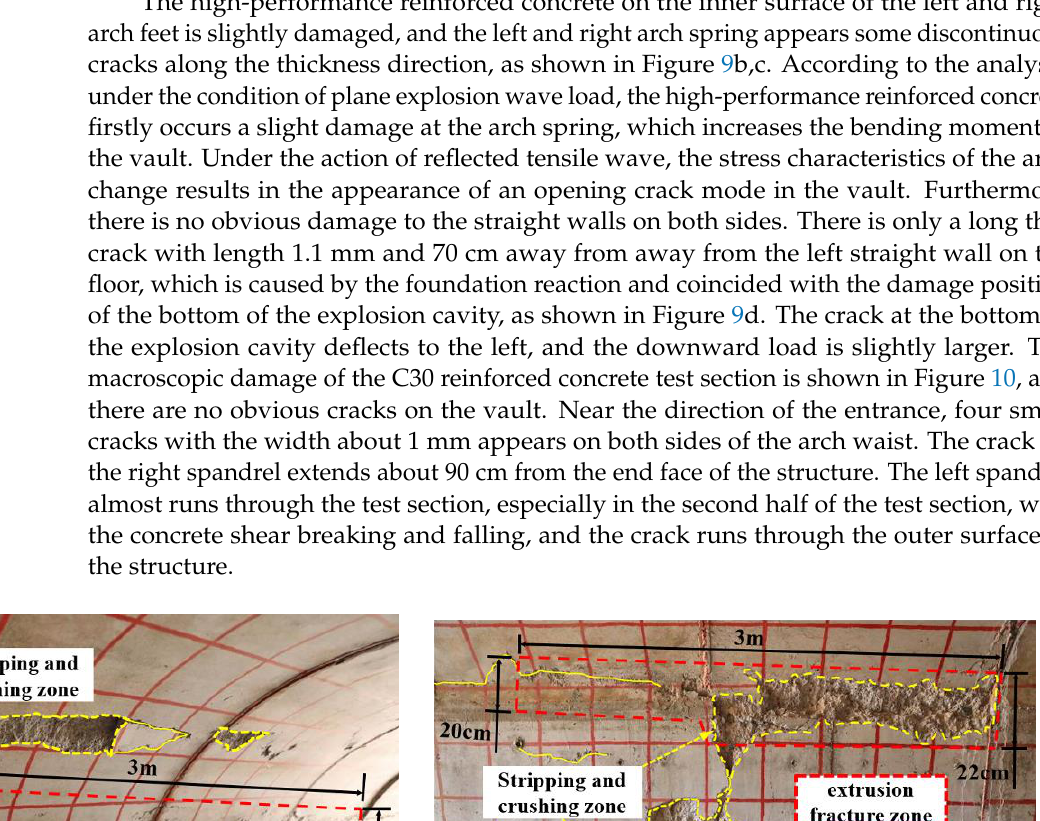
Figure 9. The damage state of test section A: ( a ) the photograph of the internal structure; ( b ) the damage state of the left arch spring; ( c ) the damage state of the right arch spring; ( d ) the damage state of the floor.